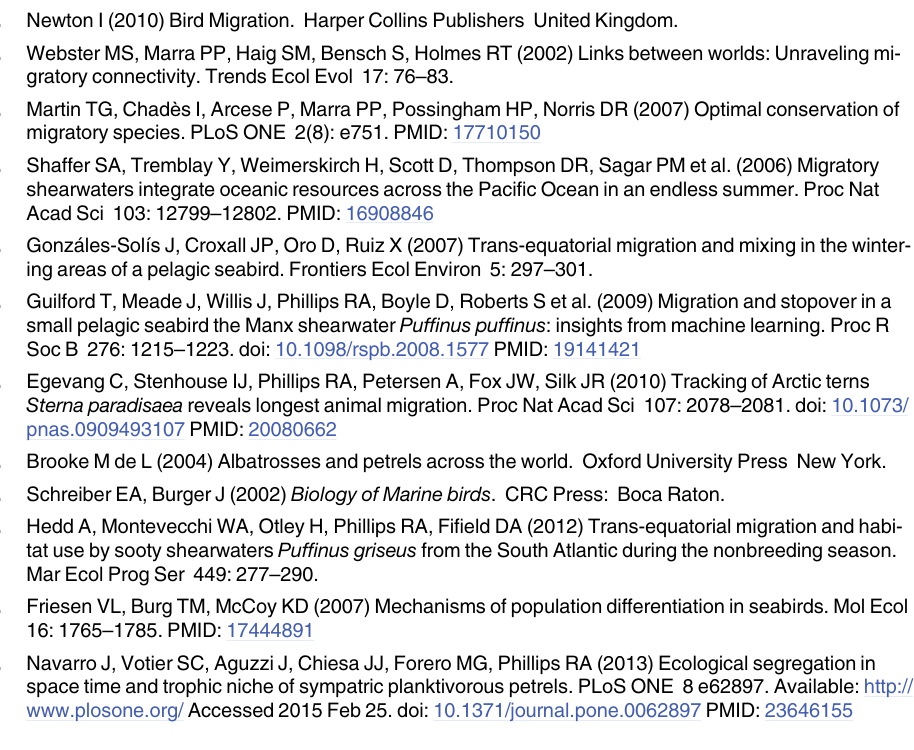
S2 Fig. Response curves for the four key parameters in the M AX E NT models of nonbreeding areas of thin-billed prions from the Falkland and Kerguelen